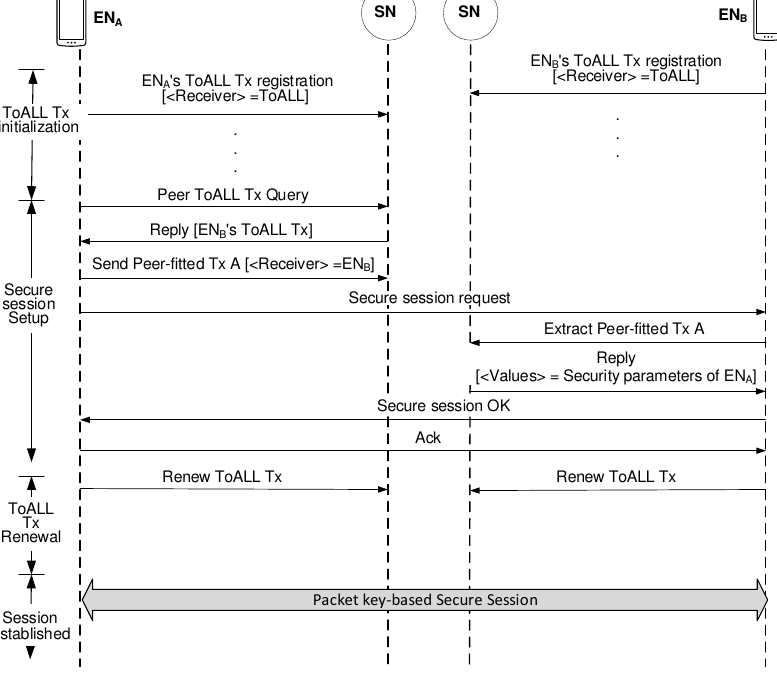
Figure 5. Security parameter agreement between peers by using